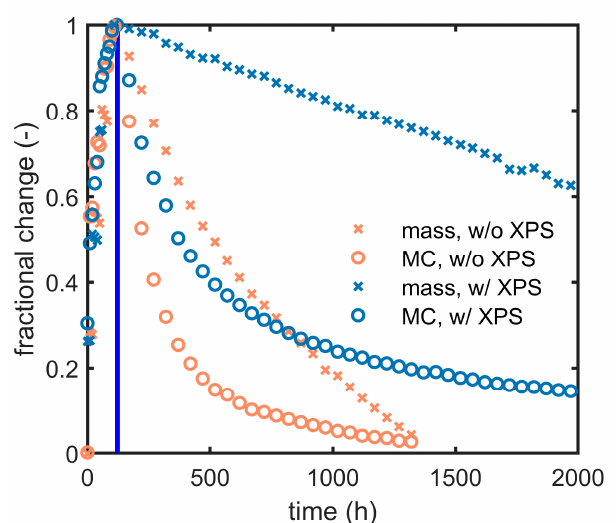
Figure 5. Fractional change in total mass and local OSB moisture content after water injection for poly walls with and without 50 mm XPS covering the OSB. For clarity, only every 50th data point is plotted for each series. The blue vertical line marks the end of the moistening phase, after which drying occurs.